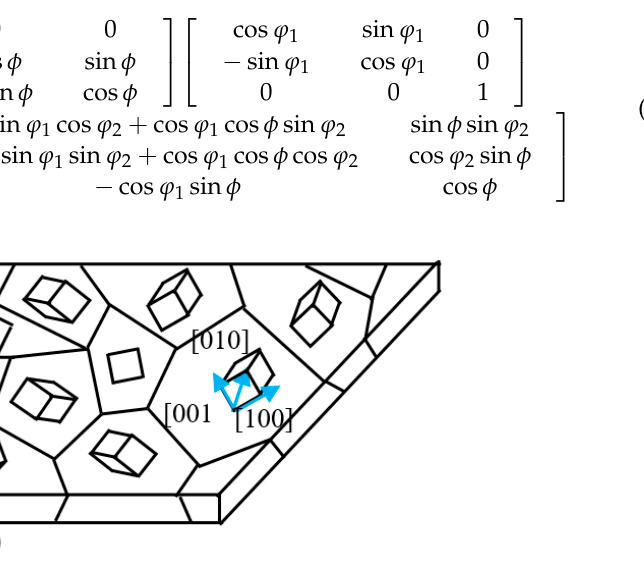
Figure 4. Schematic diagram of general grain orientation inside polycrystalline materials. When many grains in polycrystalline are oriented in one or some orientation positions, this situation is called the texture. For example, grains in oriented silicon steel with Goss texture are mostly arranged in the vicinity of the rolling direction. In the production and processing of ferromagnetic materials, after cold and hot rolling, the crystal structure of the materials show the texture phenomenon to different degrees, which cause anisotropy in the structure and performances of materials. In this study, individual grain orientation in the selected area was analyzed with EBSD